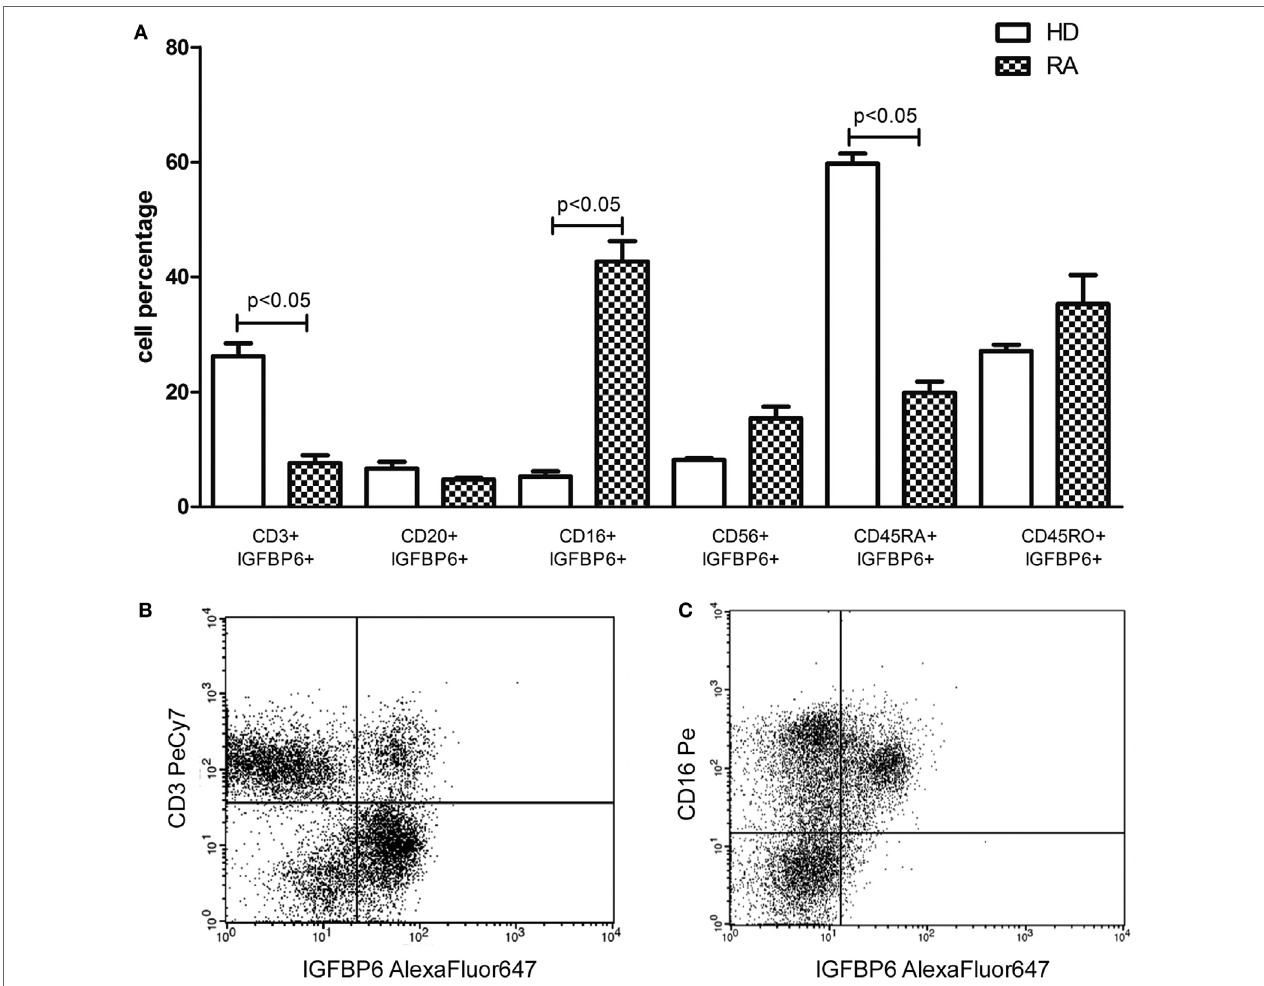
FigUre 2 | intracellular expression of insulin-like growth factor binding protein 6 (igFBP6) in peripheral blood mononuclear cells (PBMcs) from rheumatoid arthritis (ra) patients and healthy donors (hD) (a) and representative flow cytometry dot plots (B,c) gated on total PBMcs of igFBP6 expression in cD3 + cells and cD16 + cells in a patient with ra . In RA PBMCs CD16 + IGFBP6 + cell percentage is higher compared to HD while the percentage of CD3 + IGFBP6 + cells is lower compared to HD. In addition, in HD the largest proportion of IGFBP6 + T cells coexpresses CD45RA. All p values were calculated with Mann–Whitney U